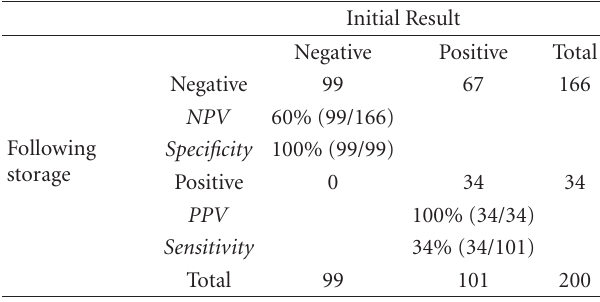
Table 2: Cross-tabulation results for the Filariasis CELISA compar- ing reactivity from paired filter paper samples following 10-month storage at − 20 ◦ C. Following storage of filter paper samples for 10 months, the reactivity of the samples reduced ( P < . 001). Sixty- seven samples became nonreactive following storage dropping the sensitivity to 34% (95%-CI 25–44) and the negative predictive value (NPV) to 60% (95%-CI 52–67). Specificity (100%) and the positive predictive value (PPV) (100%) remained unchanged following storage (95%-CI 96–100 and 95%-CI 90–100